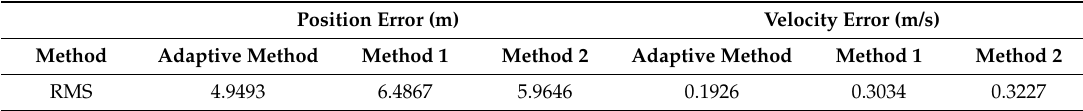
Table 2. RMSs of the position and velocity errors in Trajectory 1.